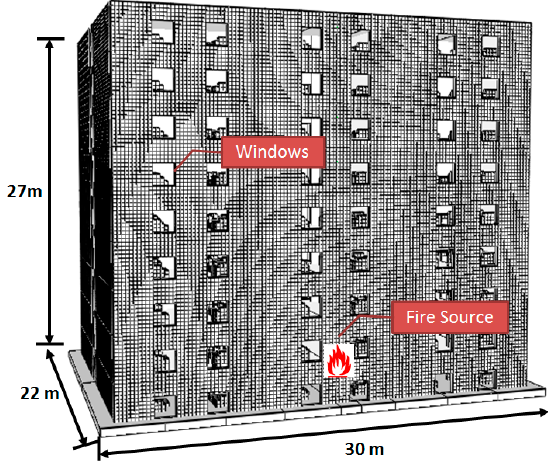
Figure 8. Numerical configuration of a representative nine-story apartment.